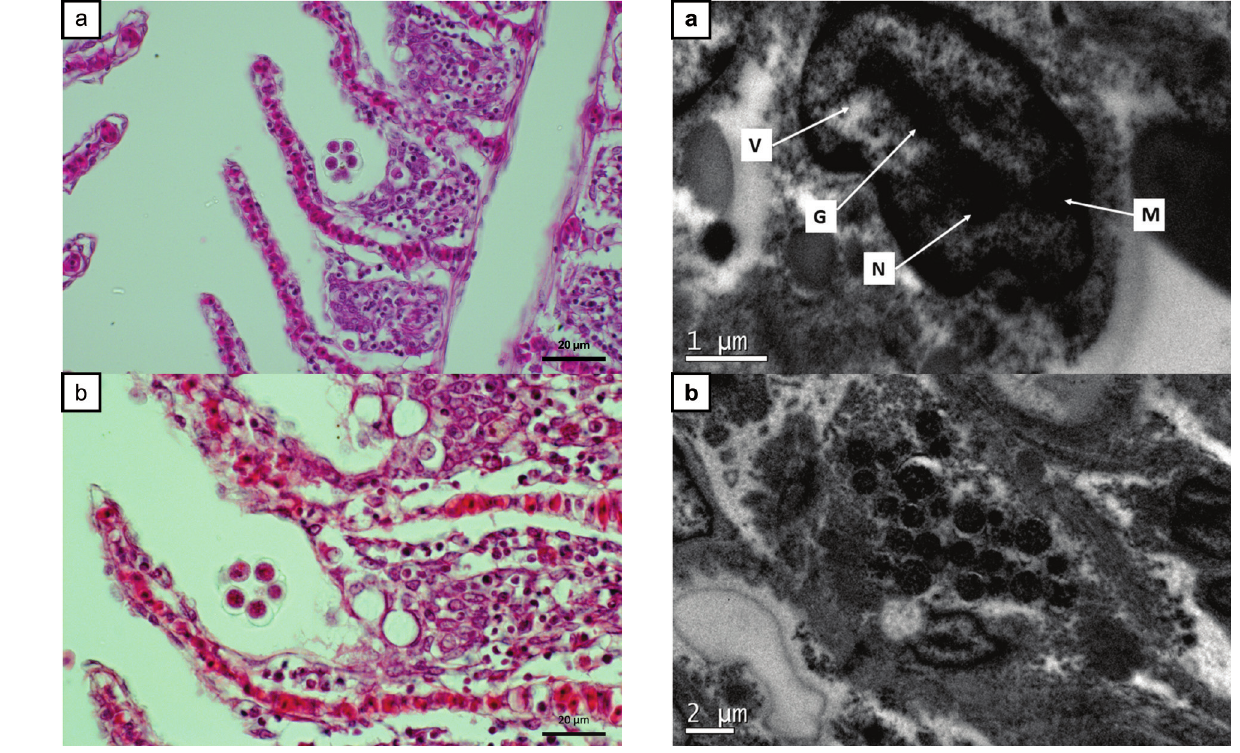
Figure 1 - Photomicrographs of the gill tissue. a. interlamellar epithelial hyperplasia along the gill filaments (bar = 20 μm). b. Spores of Dermocystidium sp. between the secondary lamellae of gills of Nile tilapia, evidencing the hyaline cytoplasm (HH & E staining, 20 μm bar).